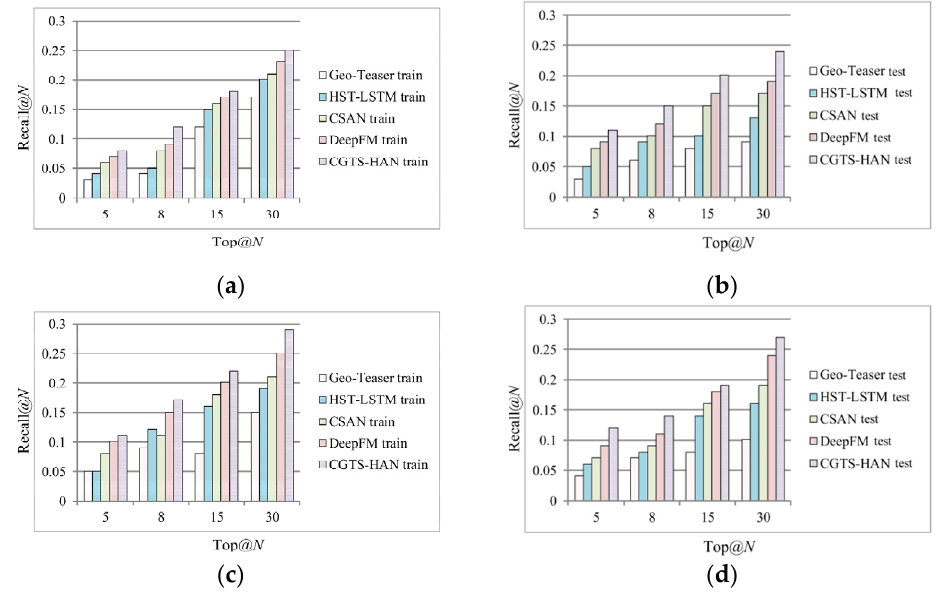
Figure 6. Comparison Results of Recall with N : ( a ) Recall of train on Foursquare; ( b ) Recall of test on Foursquare; ( c ) Recall of train on Yelp; ( d ) Recall of test on Yelp.